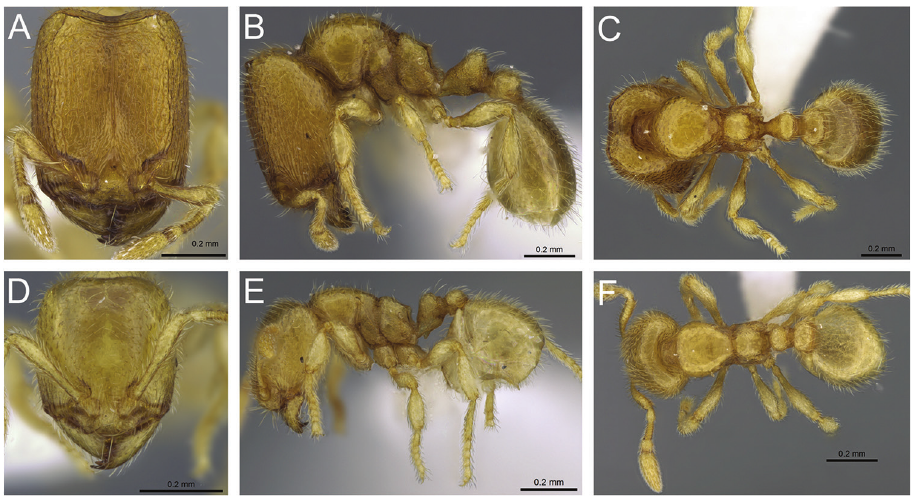
Figure 41. Carebara hainteny –holotype. Major worker, CASENT0410494: A head in full-face view B body in profile view C body in dorsal view. Minor worker, CASENT0410542: D head in full-face view E body in profile view F body in dorsal